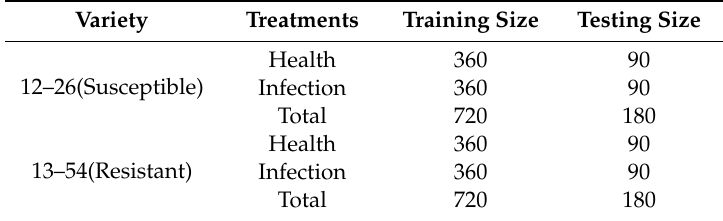
Table 1. Information regarding healthy and infected samples for